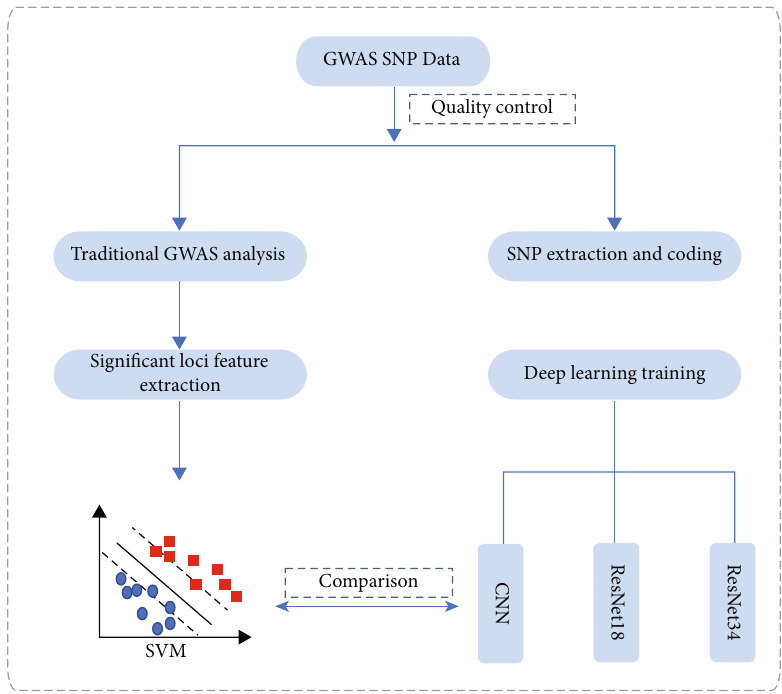
Figure 1: The fl owchart of experimental procedures in this study.